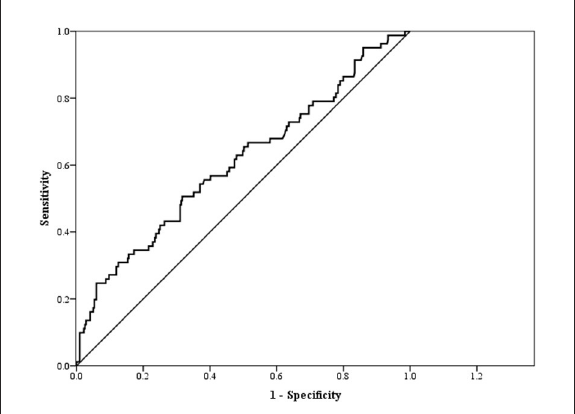
FIGURE2 Receiver operating characteristic (ROC) curve for triglyceride/high-density lipoprotein-cholesterol (TG/HDL-C) as a predictor of chronic kidney disease (CKD).